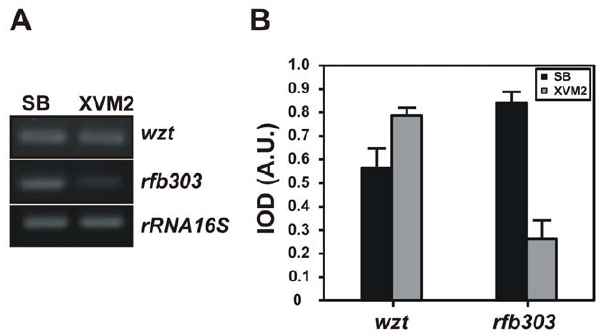
Figure 6. Expression of Xac LPS genes in the plant-mimicking XVM2 medium. (A) Amplified products of the wzt and rfb303 genes